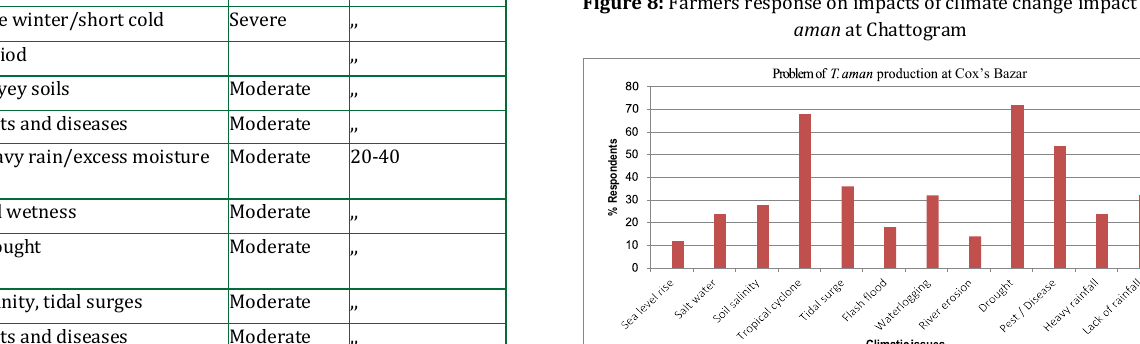
Figure 8: Farmers response on impacts of climate change impact of T.